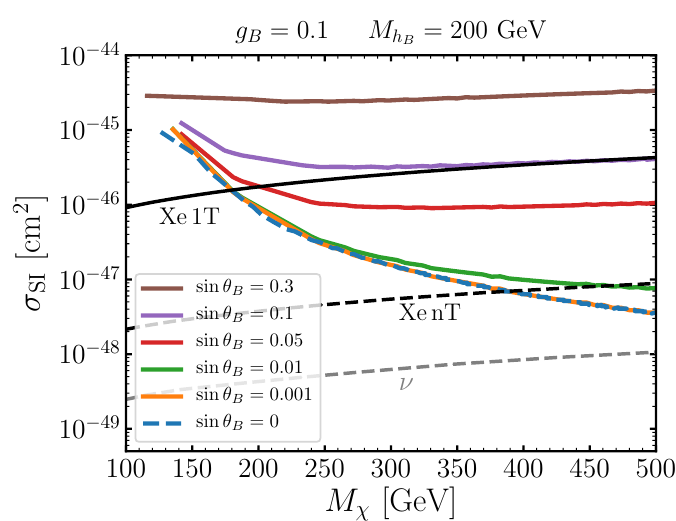
Figure 3 . Predictions for the direct-detection spin-independent cross-section as a function of the dark matter mass. The purple, red, green and orange lines correspond to sin θ = 0 . 1 , 0 . 05 , 0 . 01 B and 0 . 001 , respectively. The brown line corresponds to the maximal mixing scenario, sin θ = 0 . 3 , B while the blue dashed line represents the minimal one, θ = 0 . All points give the measured relic B abundance by the Planck satellite Ω 2 = 0 . 1200 ± 0 . 0012 [19] and satisfy constraints from the χ h LHC. The solid black line shows current experimental bounds from Xenon-1T [20, 25], the dashed black line shows the projected sensitivity for Xenon-nT [21] and the dashed gray line shows the coherent neutrino scattering limit